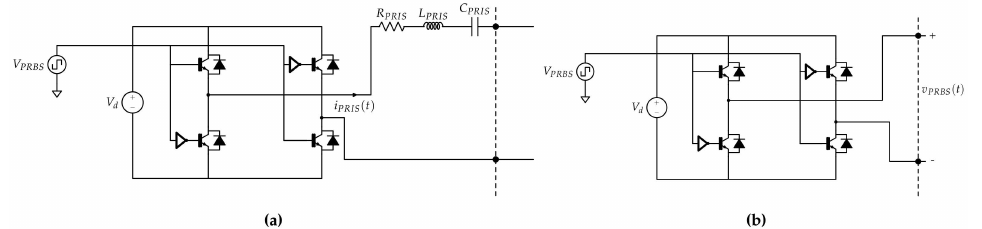
Figure 10. Circuit configuration of a ( a ) PRIS source and a ( b ) PRBS